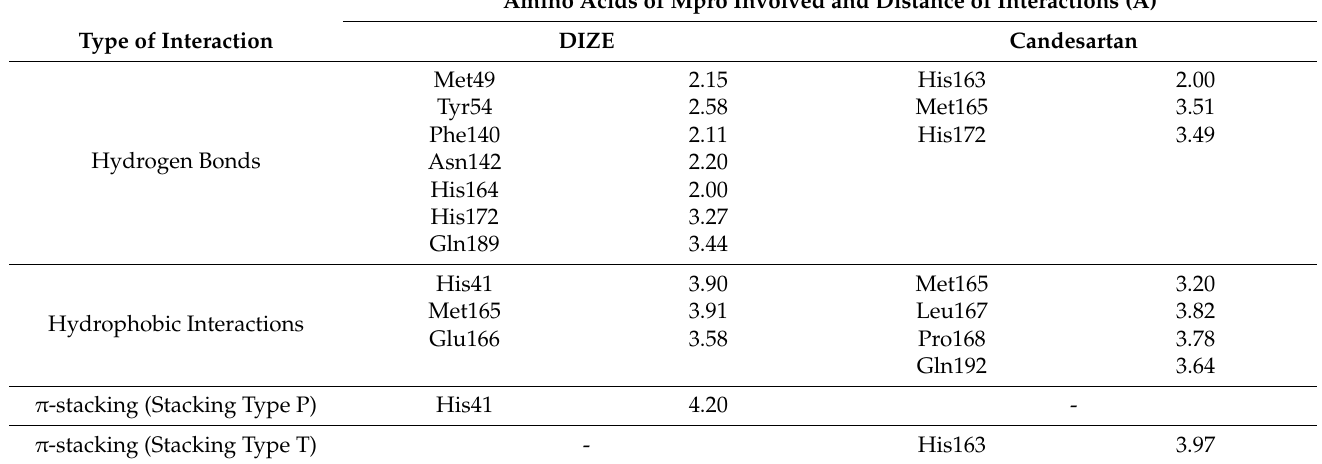
Table 2. Interactions of amino acid residues of the main protease of SARS-CoV-2 (PDB ID: 6LU7) with DIZE and candesartan using PLIP. Amino Acids of Mpro Involved and Distance of Interactions (Å)